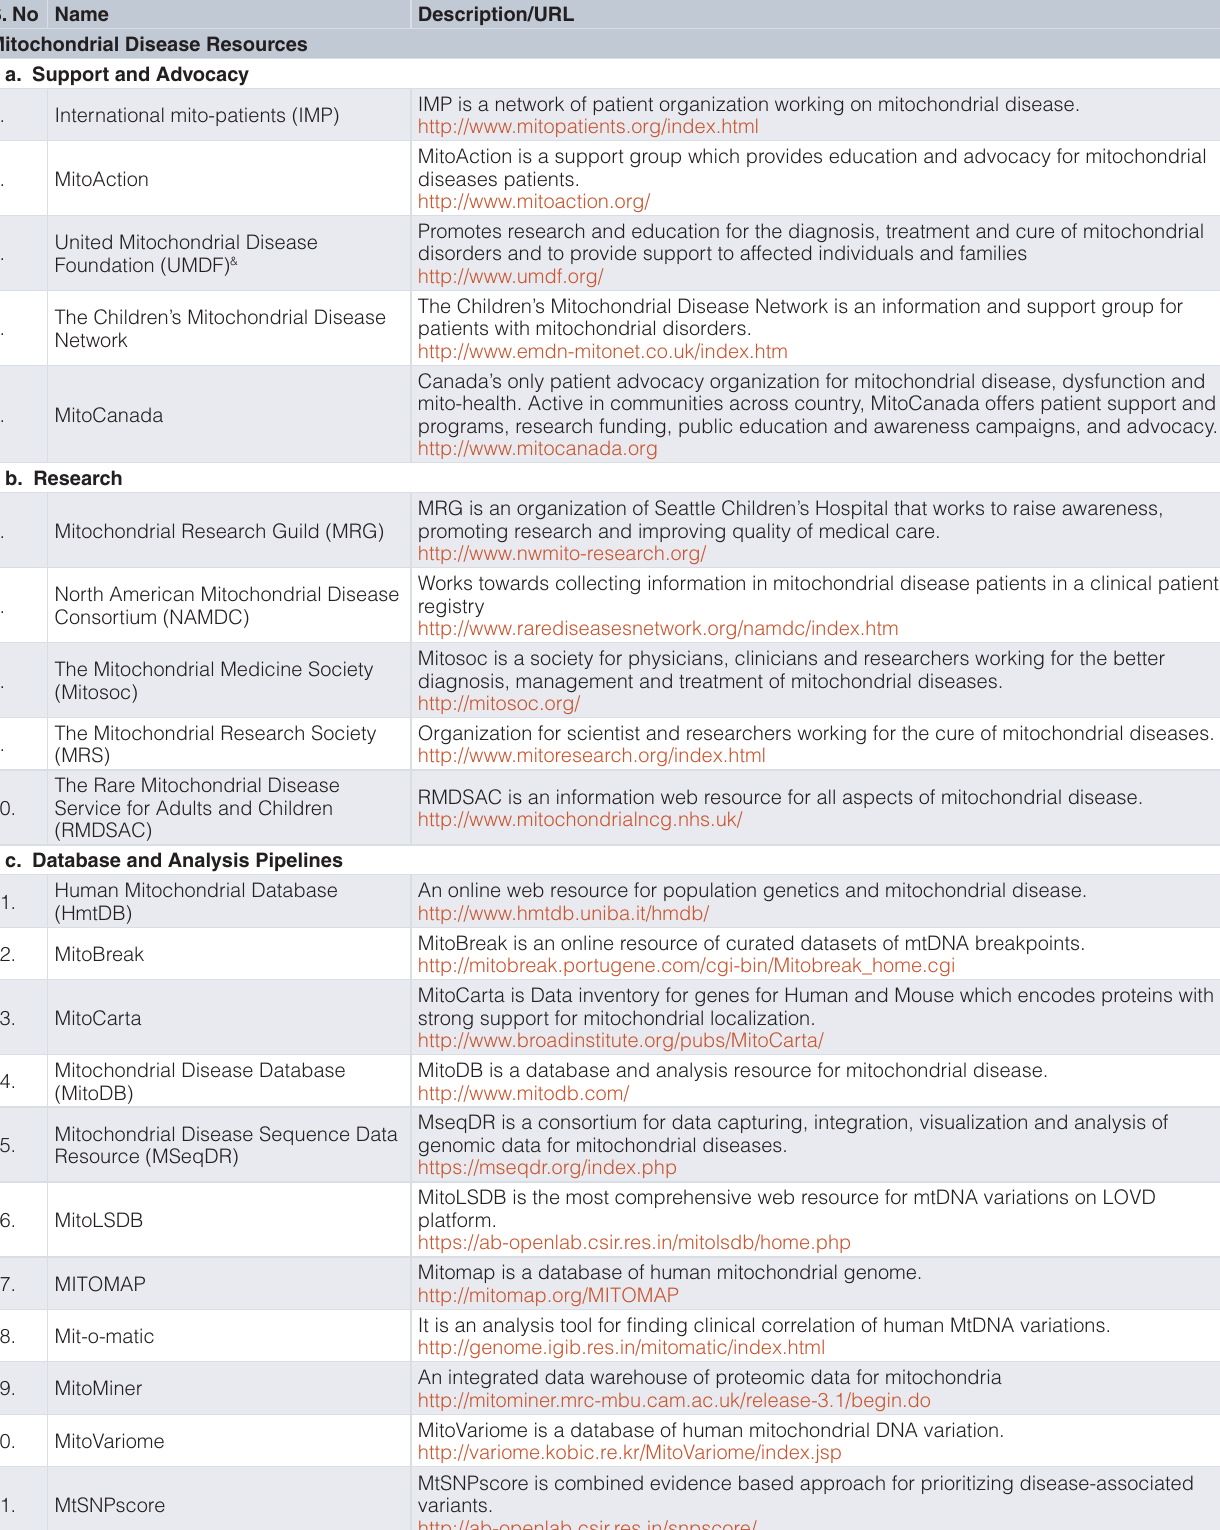
Table 1. Lists of mitochondrial and rare diseases resources. There are a large number of resources developed both for mitochondrial community and rare diseases community. The first section lists the resources available on mitochondrial diseases including Support and Advocacy groups * , databases and analysis pipelines # , research & and patient networks $ . The second section lists resources on rare